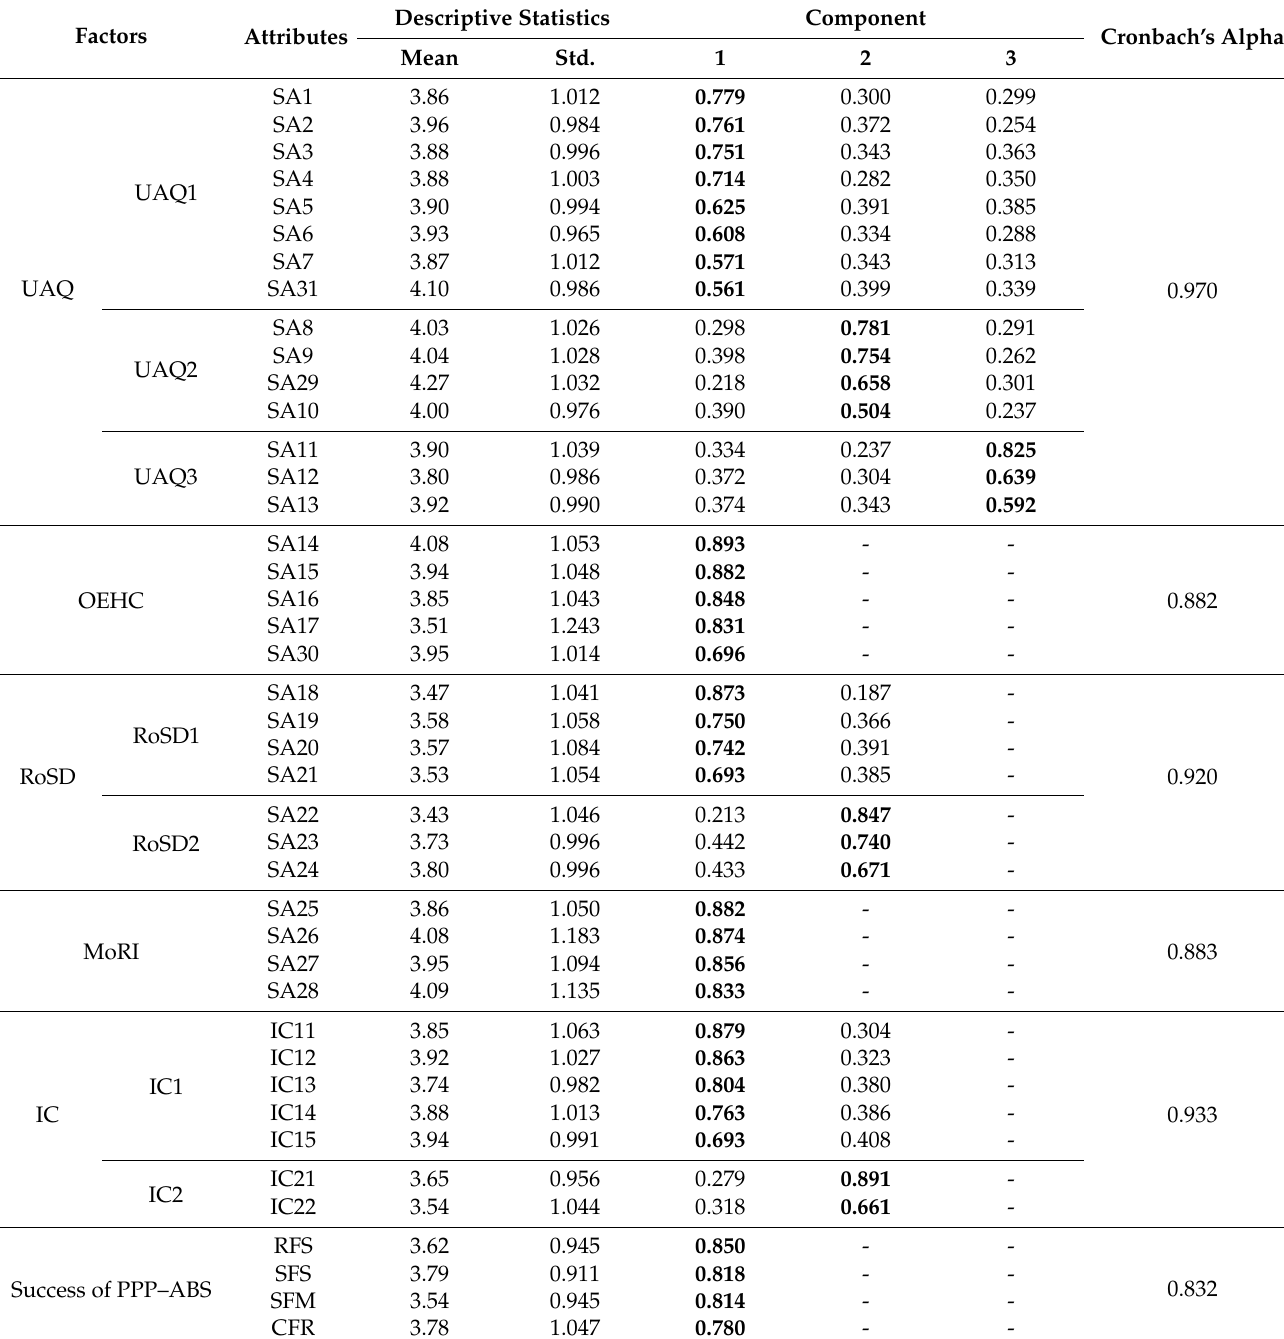
Table 5. Reliability analysis and factor analysis (Source: Authors’